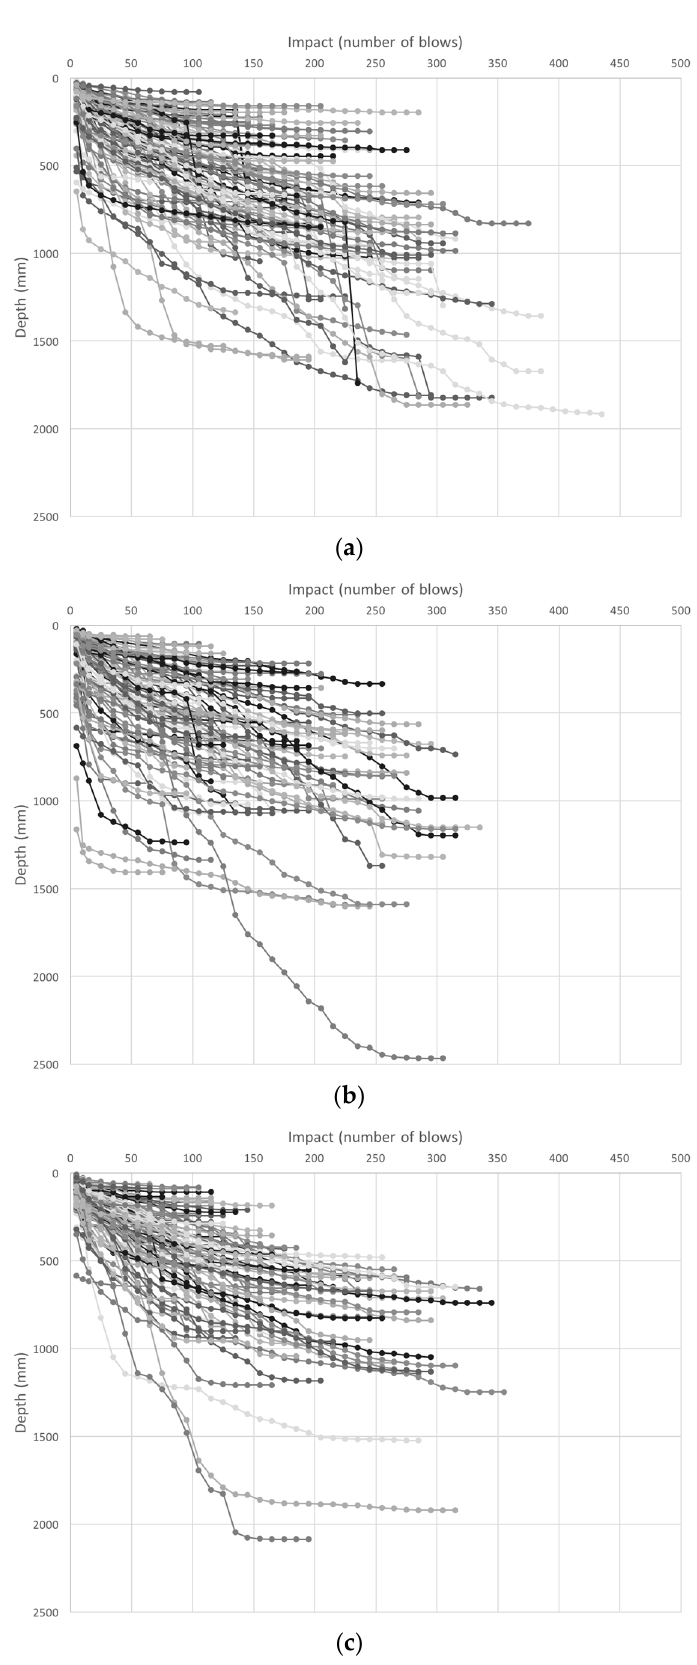
Figure 4. Sludge strength variation with depth in areas of ( a ) Luwinga; ( b ) Ching’ambo; and ( c ) Masasa. Lines represent individual test results in each area.